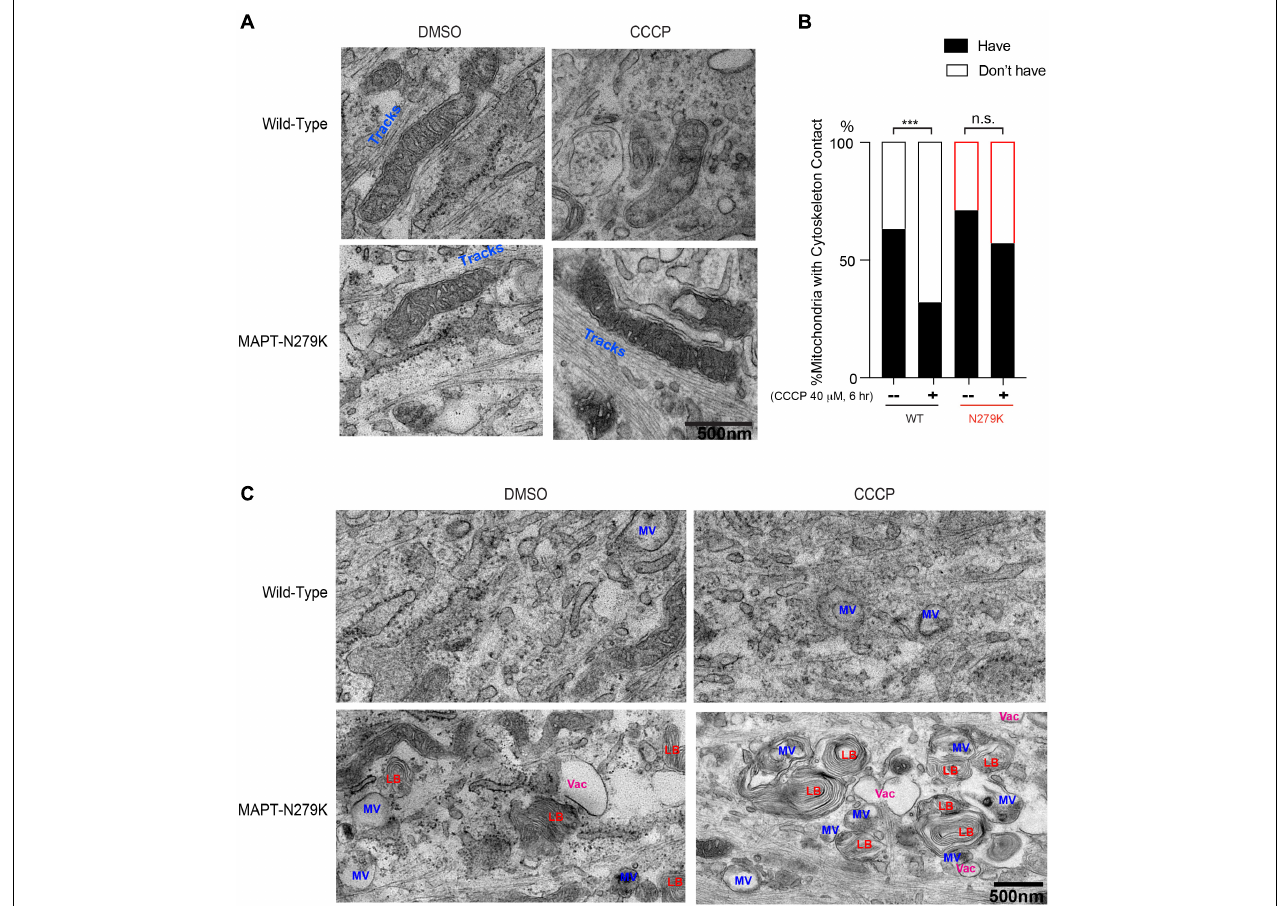
FIGURE 3 | Phenotypes of cytoskeleton and other organelles in fibroblasts. (A) Representative TEM images of Healthy-6 (WT) and MAPT-1 (MAPT-N279K) with and without CCCP treatment, showing cytoskeleton tracks (Tracks) next to mitochondria. (B) From images as in (A) , the percentage of total mitochondria with or without adjacent cytoskeleton tracks is counted. N = 30 (WT, DMSO), 28 (WT, CCCP), 31 (MAPT-N279K, DMSO), and 36 (MAPT-N279K, CCCP) mitochondria from 15 images from 3 independent cultures. Chi Square Test. (C) Representative TEM images of Healthy-6 (WT) and MAPT-1 (MAPT-N279K) with and without CCCP treatment, showing vacuole-like structures (Vac), structures similar to multi-vesicular bodies (MV), and structures similar to lamellar bodies (LB). Scale bars: 500 nm. *** P < 0.001. n.s.: not significant.